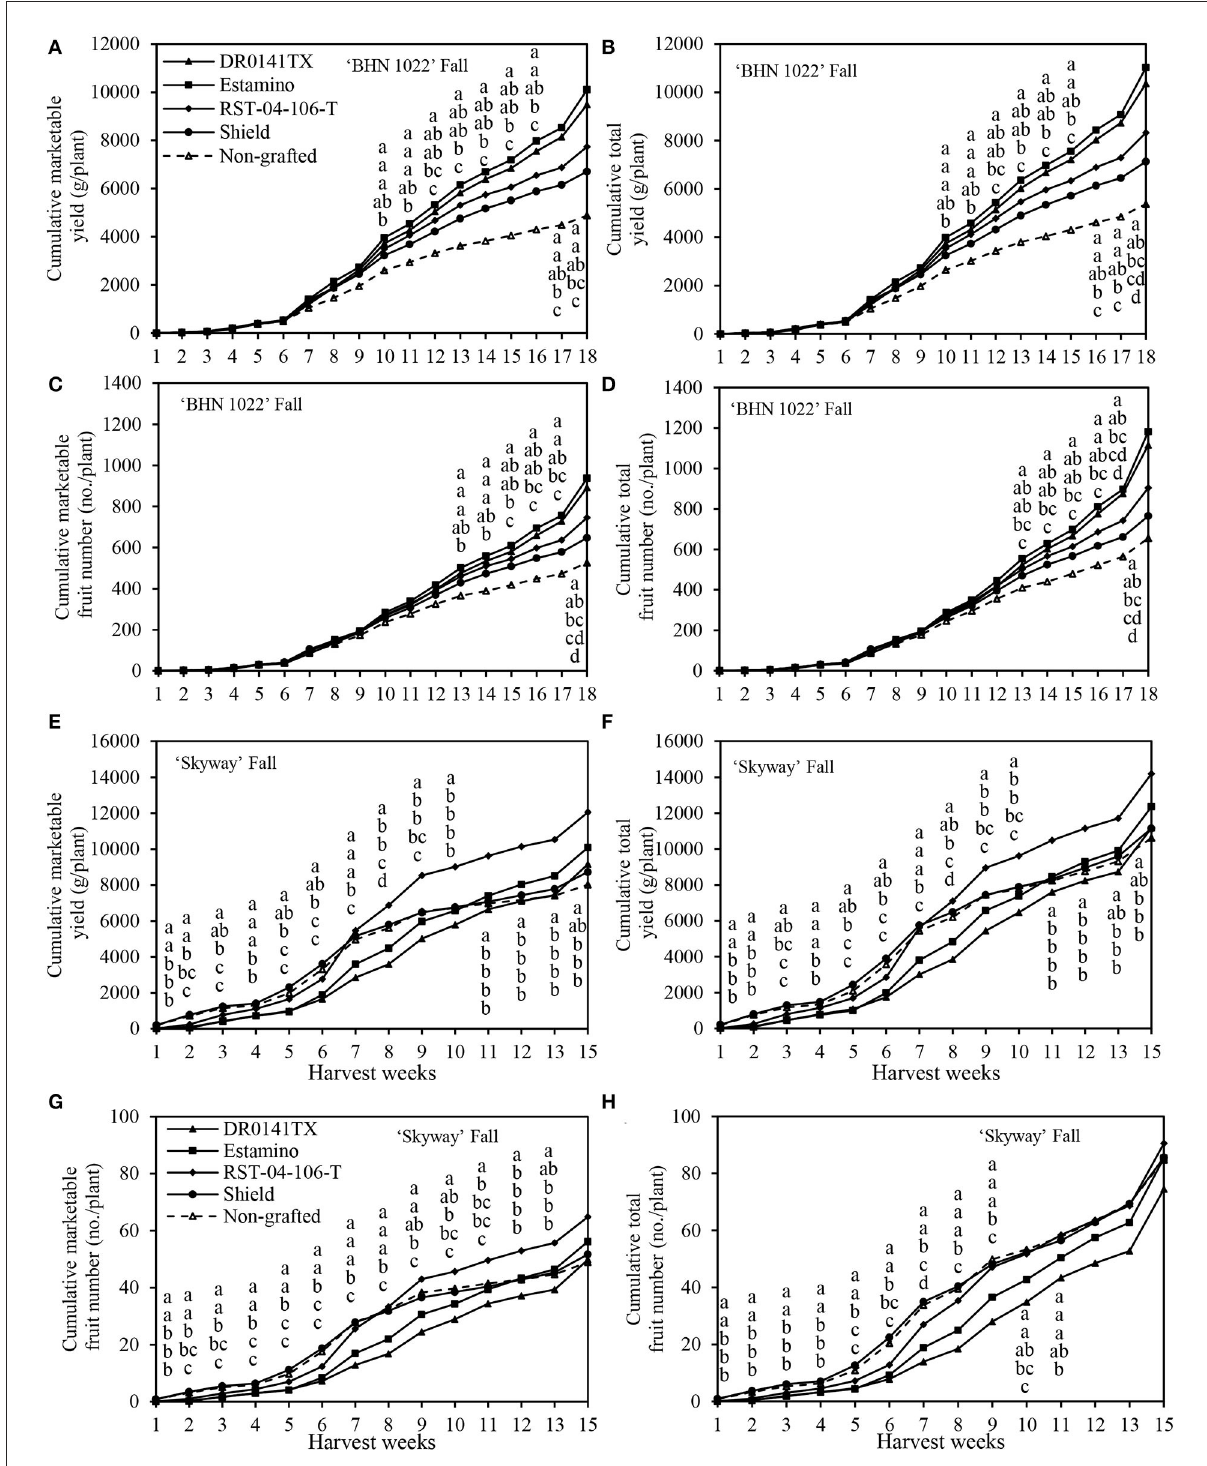
FIGURE4 Cumulative marketable and total fruit weights and numbers of the grafted ‘BHN 1022’ grape tomato and ‘Skyway’ beefsteak tomato scions in the fall planting (24 September 2020 to 15 April 2021). Green fruits at final harvest were excluded. (A) Cumulative marketable yield of ‘BHN 1022’. (B) Cumulative total yield of ‘BHN 1022’. (C) Cumulative marketable fruit number of ‘BHN 1022’. (D) Cumulative total fruit number of ‘BHN 1022’. (E) Cumulative marketable yield of ‘Skyway’. (F) Cumulative total yield of ‘Skyway’. (G) Cumulative marketable fruit number of ‘Skyway’. (H) Cumulative total fruit number of ‘Skyway’. For the same harvest week, data with the same letter are not significantly different at P ≤ 0.05 according to Fisher’s LSD